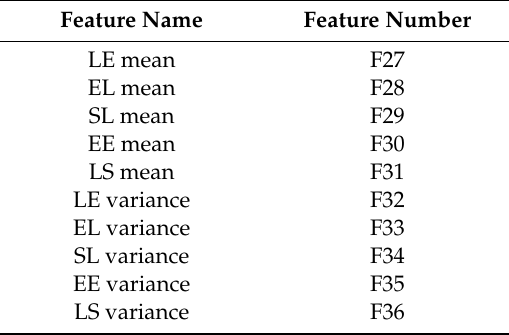
Table 6. Laws’ texture energy matrix feature sets.